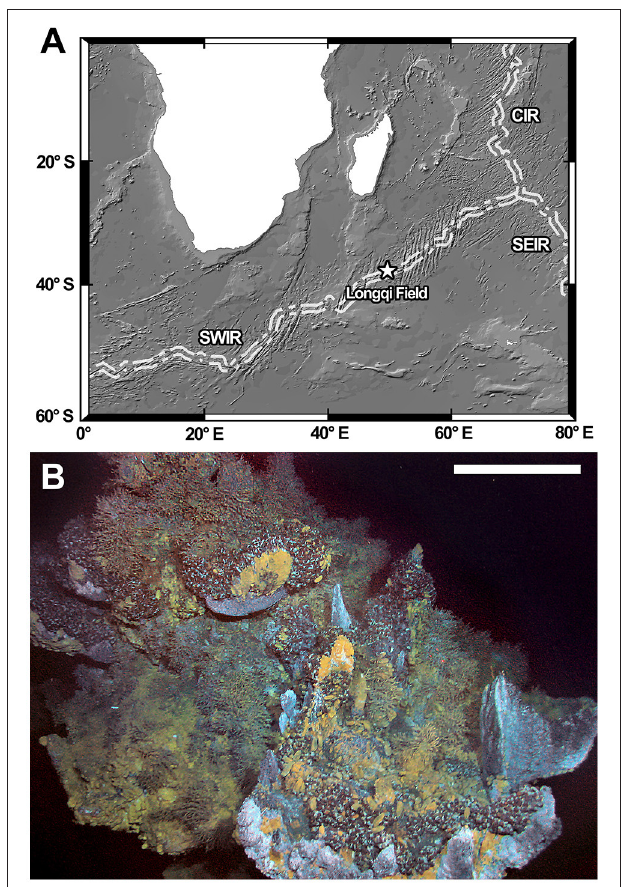
FIGURE 1 | (A) Location of the Longqi vent field on the Southwest Indian Ridge. (B) The “Tiamat” Chimney where the two small peltospirids were first collected. Scale bar = approximately 1m on the foreground. Abbreviations: CIR, Central Indian Ridge; SEIR, Southeast Indian Ridge; SWIR, Southwest Indian Ridge.